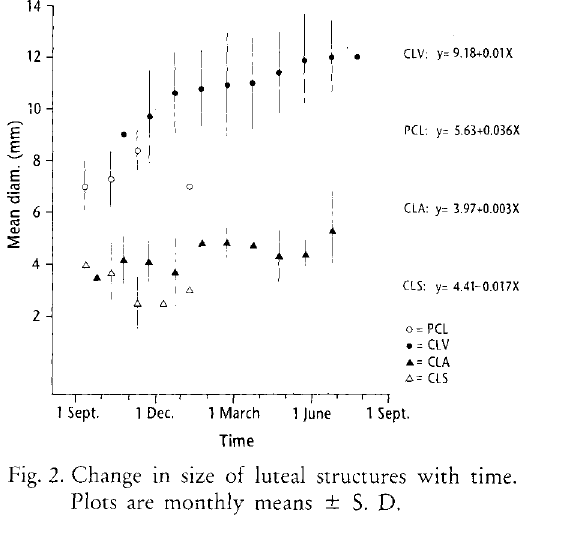
Fig. 2. Change in size of luteal structures with time. Plots are monthly means ± S. D.